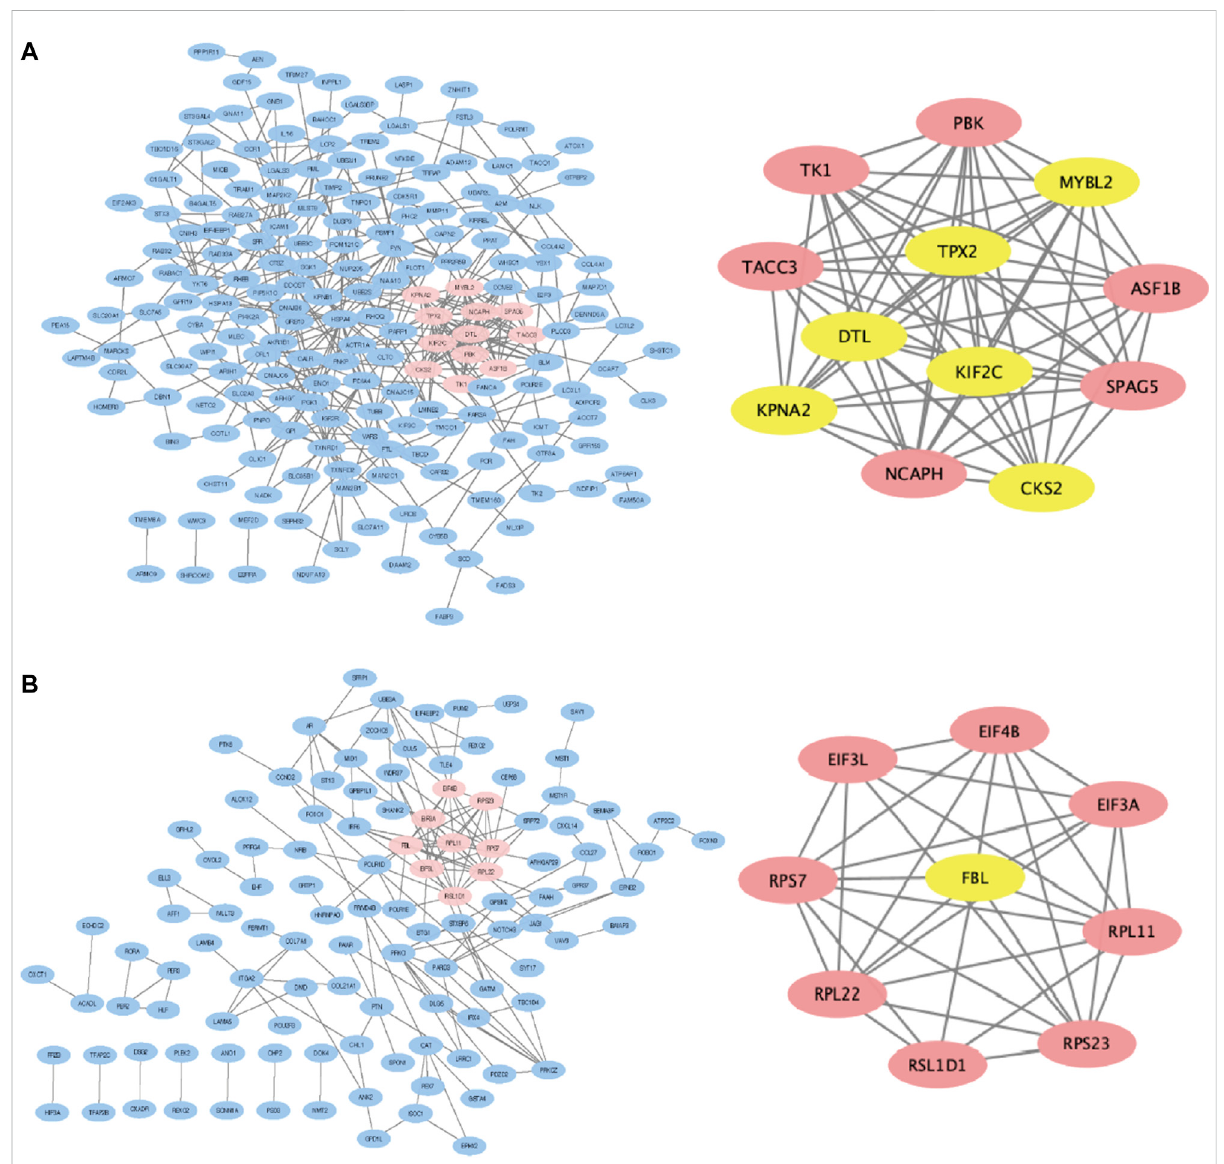
FIGURE 4 PPI network and most related modules of methylation-regulated differentiallyexpressed genes. (A) Hypomethylated upregulated genes. (B) Hypermethylated downregulated